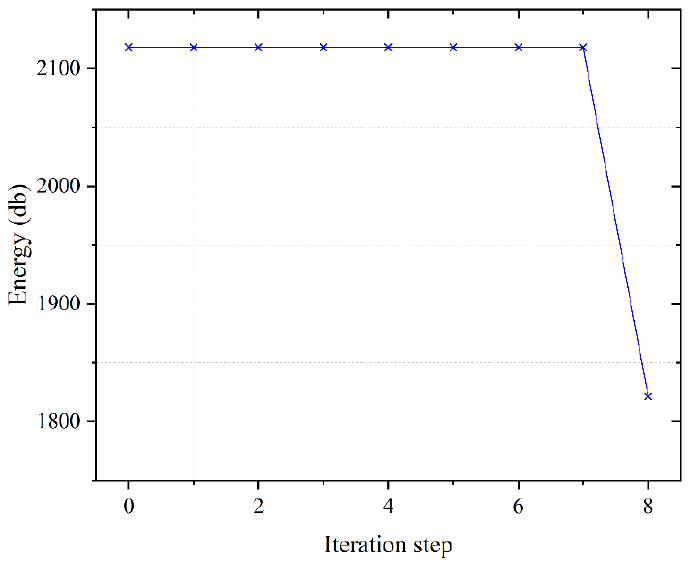
Figure 21. Iterative convergence curve for vibration reduction optimization of the PAF (FOM).